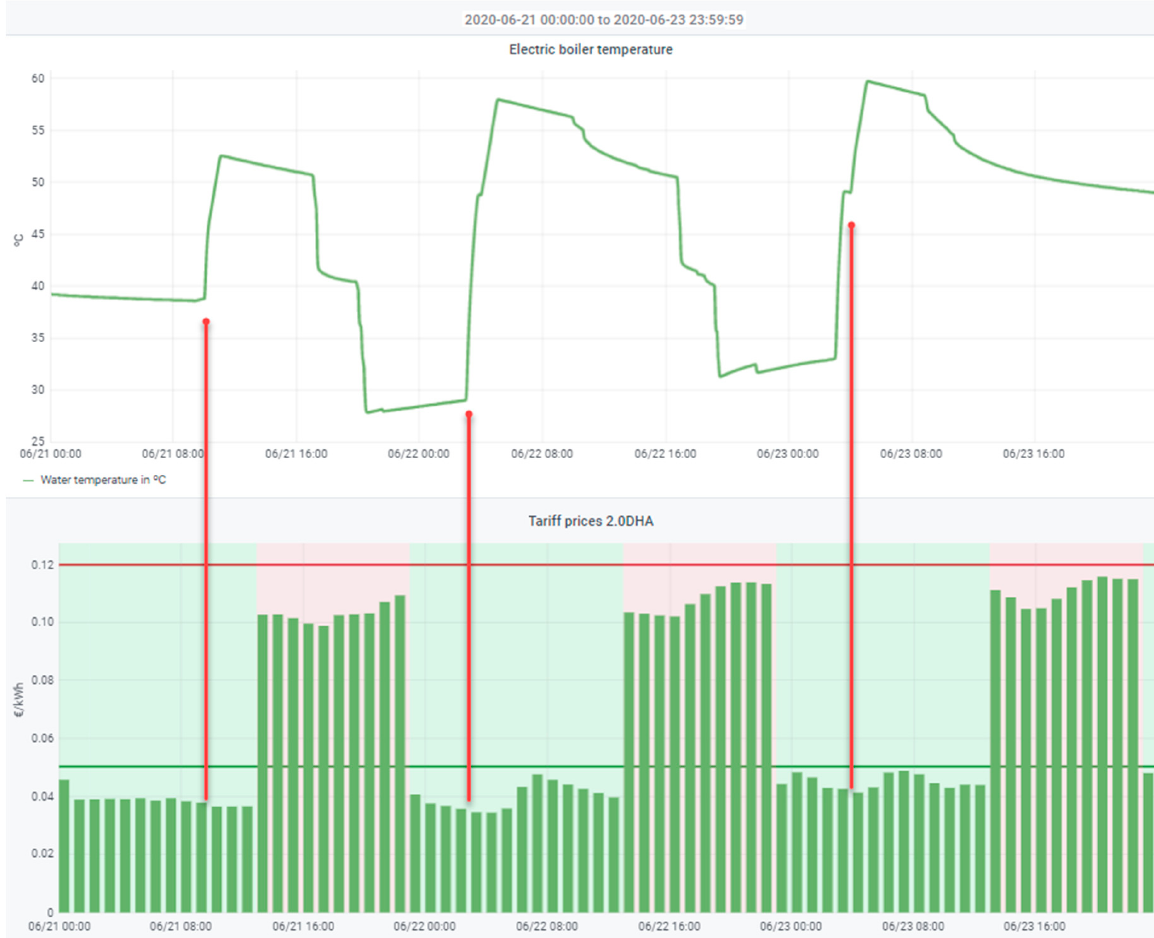
Figure 8. Heating of the water in the electric boiler during the most economical hours. The heating cycle of the boiler is displayed, and the heating hours are marked. Data from 21 June 2020 00:00:00 to 23 June 2020 23:59:59.